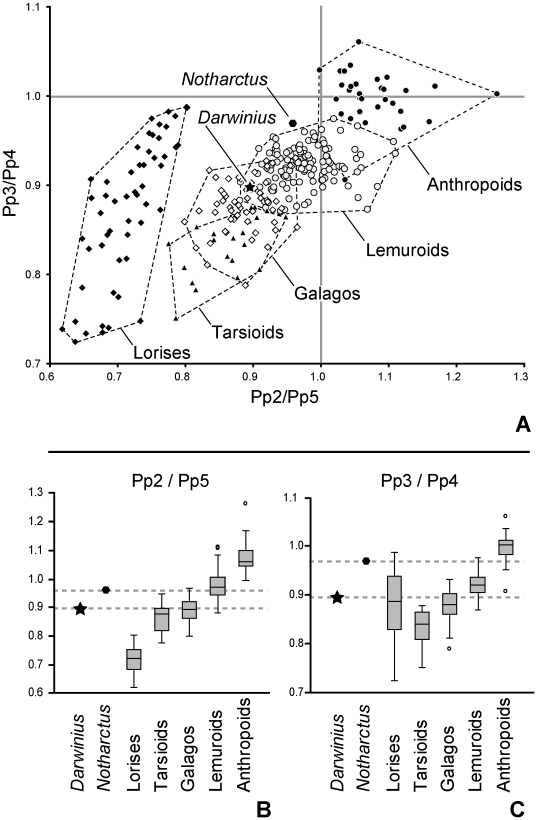
Plots of pp2 length/pp5 length and pp3 length/pp4.A, Bivariate plot of pp2/pp5 length and pp3/pp4 length: closed circles (anthropoids); closed triangles (tarsiiforms); closed diamonds (lorises); open diamonds (galagos); open circles (lemuroids); closed octagon (Notharctus); closed star (Darwinius). Abbreviations: Pp, proximal phalanx; Mt, metatarsal. B, Univariate boxplots of pp2/pp5 length. C, univariate boxplots of pp3/pp4 length. Dashed lines in A and B show position of fossils relative to extant groups.